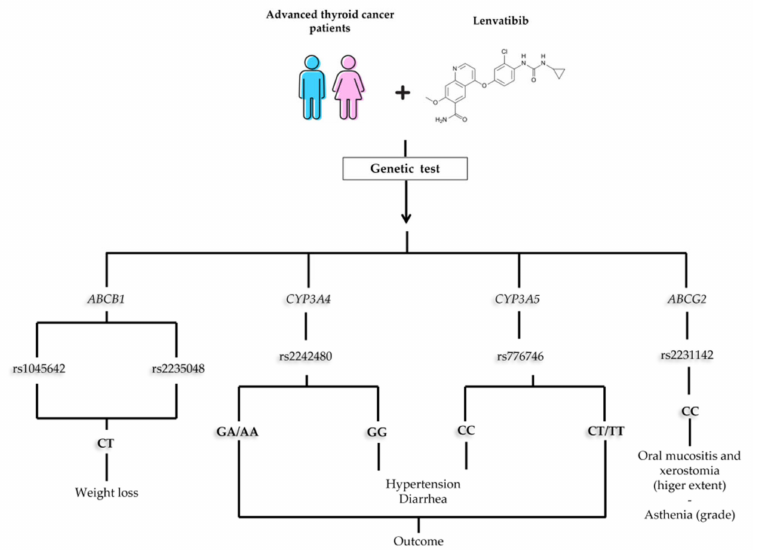
Figure 1. Suggested flowchart of genetic analysis at the beginning of therapy with